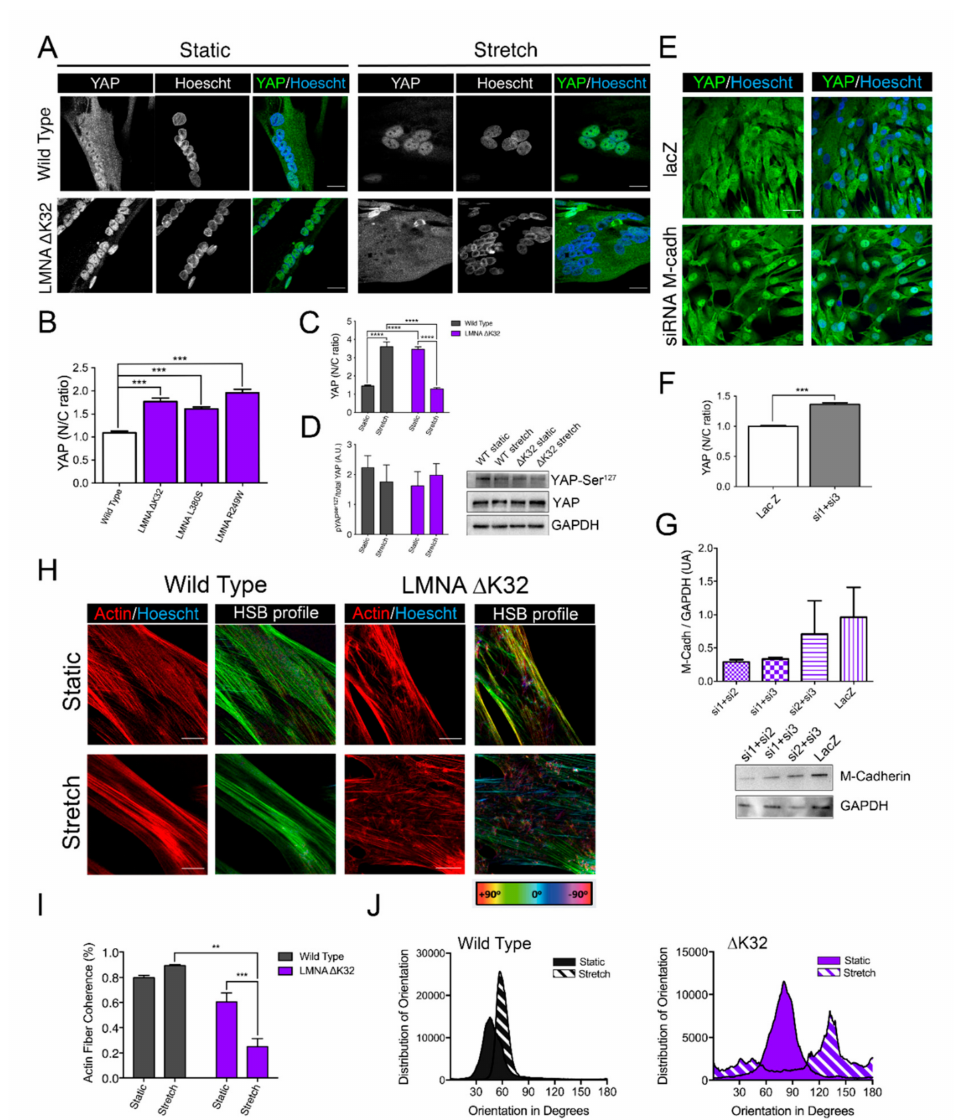
Figure 4. Adaptability of WT and LMNA ∆ K32 myotubes to cyclic stretch ( A ) Yes-associated protein (YAP, in green) in WT and LMNA ∆ K32 mutant myotubes (72 h differentiation) in static and after stretch. Nuclei are stained with Hoechst (blue). Scale bar: 20 µ m ( B ) Quantification of YAP nucleo-cytoplasmic (N/C) ratio in WT and LMNA mutant myotubes.